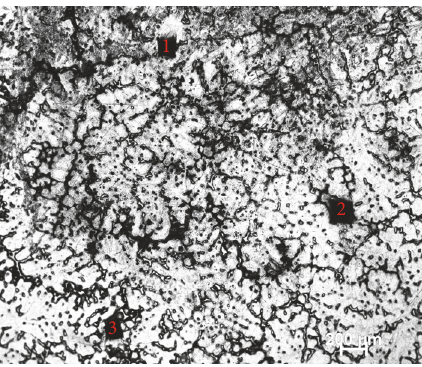
Figure 1: CLSM micrograph showing the Vickers impressions on the surface of the etched AZ91D alloy.